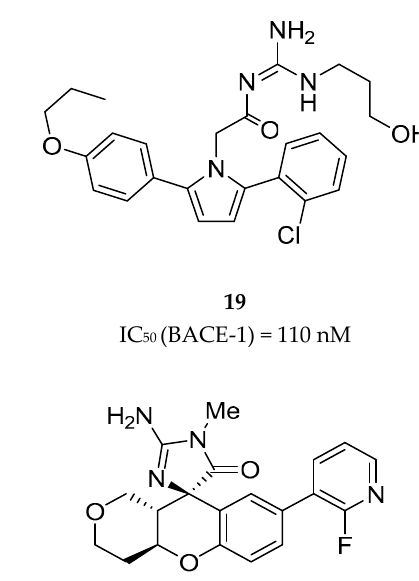
Table 4 . Pockets and their amino acid residues on the catalytic domain of BACE-1 [64]. Pocket